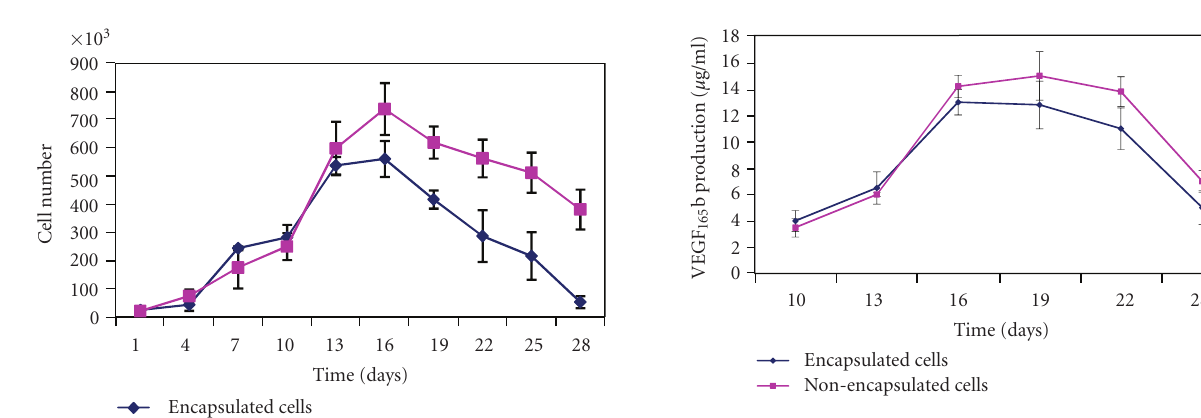
Figure 1: The number of viable encapsulated and nonencapsulated HEK293 VEGF 165 b producing cells determined by MTS assay.